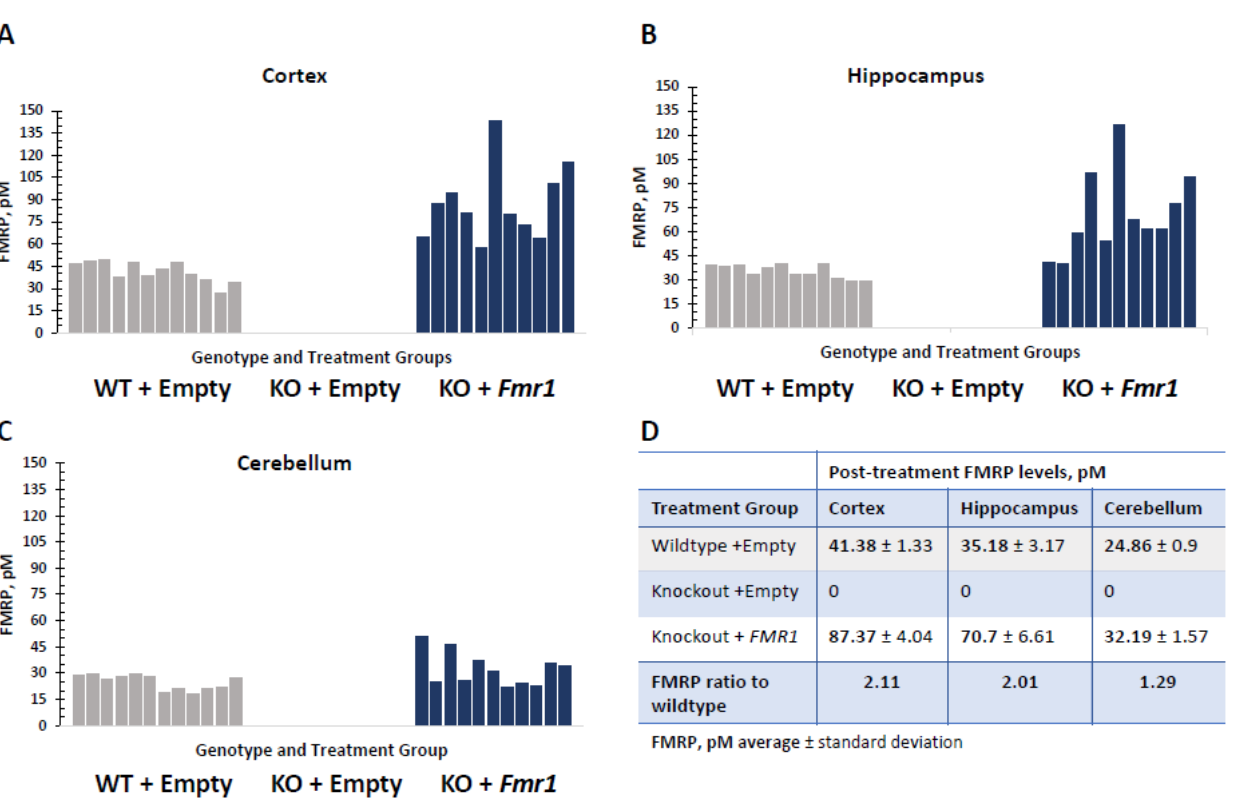
Figure 2. FMRP expression in different brain regions in Fmr1 -treated KO mice (KO + Fmr1) compared to wildtype (WT + Empty) or KO (KO + Empty) mice that were treated with an empty vector. The FMRP levels in the cortex ( A ), hippocampus ( B ), and cerebellum ( C ), where each bar represents individual animals of each treatment group, are shown in the corresponding panels. Wildtypes (WT-) are shown in gray, and Fmr1 -treated knockout (KO+) are shaded blue. The average FMRP expression per treatment group in the mouse brain structures is shown in the table ( D